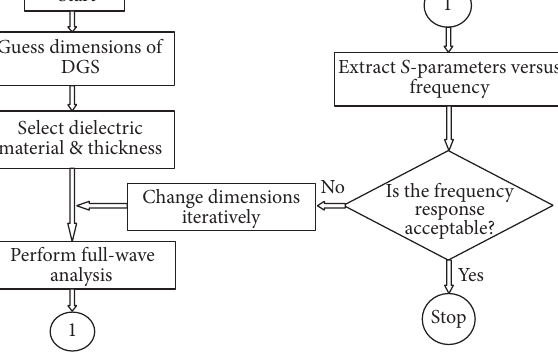
Figure 3: Flowchart of design and analysis of conventional dumb- bell DGS [32].